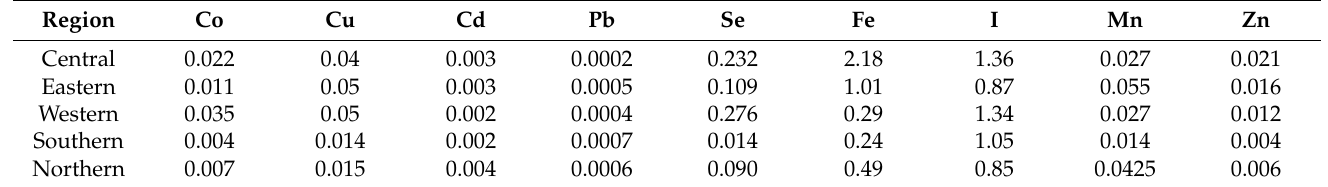
Table 1. The mineral concentration [ppb] in representative soil * samples from the five regions.